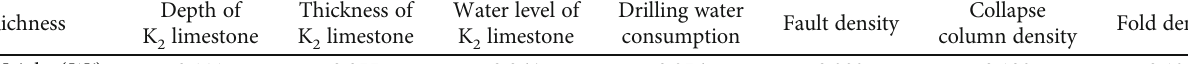
Table 7: The weight of local learning information in aquifer water richness analysis.